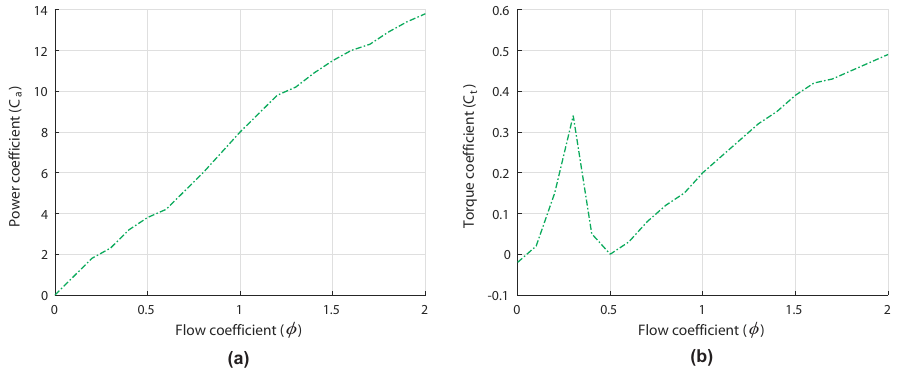
Figure 3. Wells turbine’s characteristic curves. ( a ) Power coefficient against flow coefficient. ( b ) Torque coefficient against flow